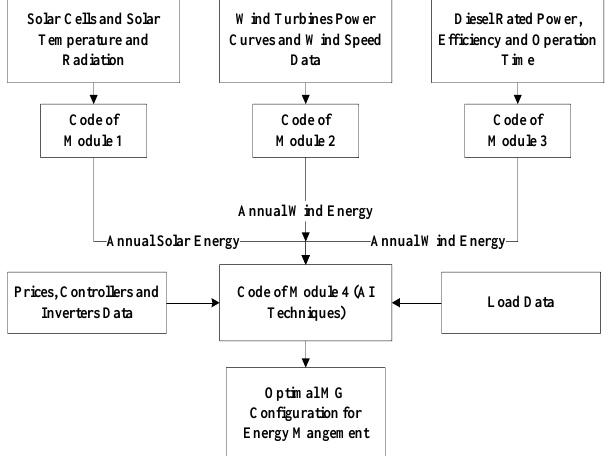
Figure 2. Modules of the suggested optimization